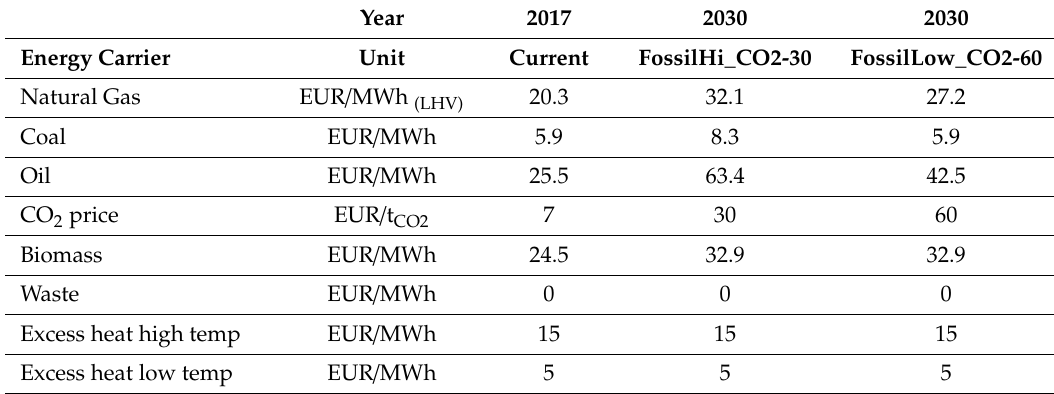
Table A2. Wholesale energy carrier and CO 2 prices for the di ff erent scenario sets (Sources: [13–15]).